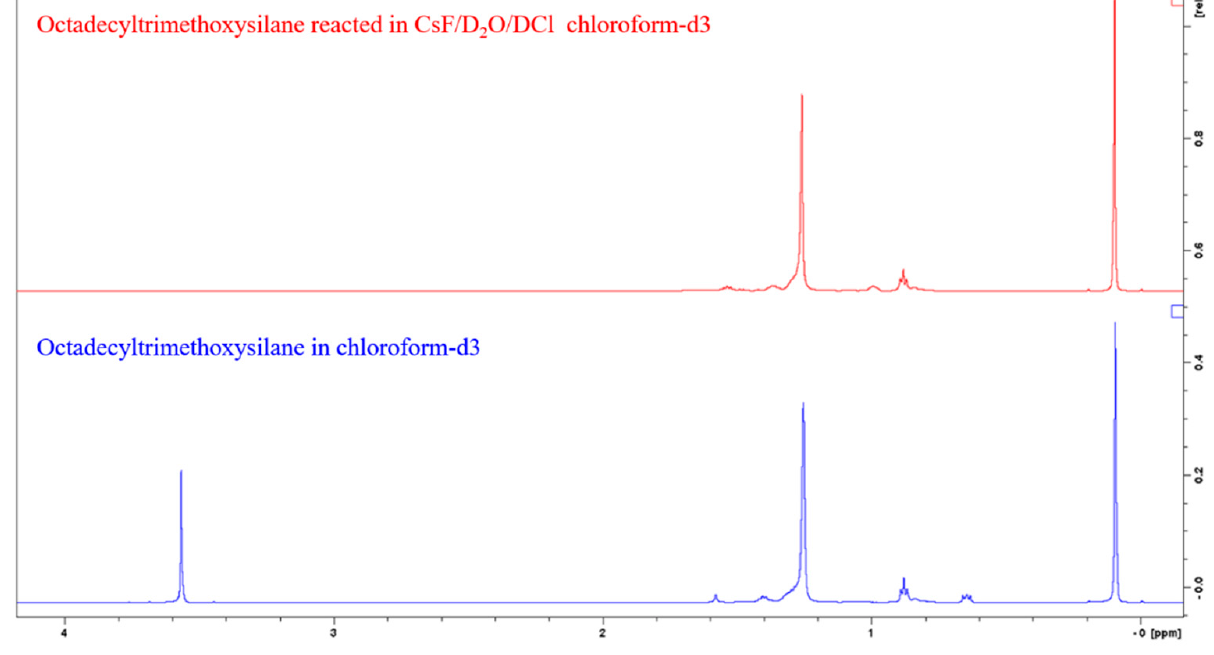
Figure 4. 1 H spectra of C18 silane in chloroform ( bottom ), and reacted in CsF/D 2 O/DCl and extracted with chloroform ( top ).